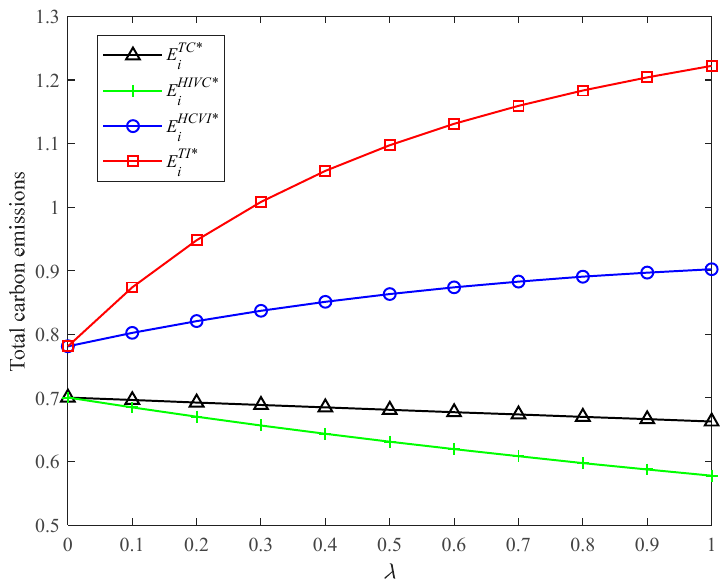
Figure 6. Total carbon emissions in four models with different λ .